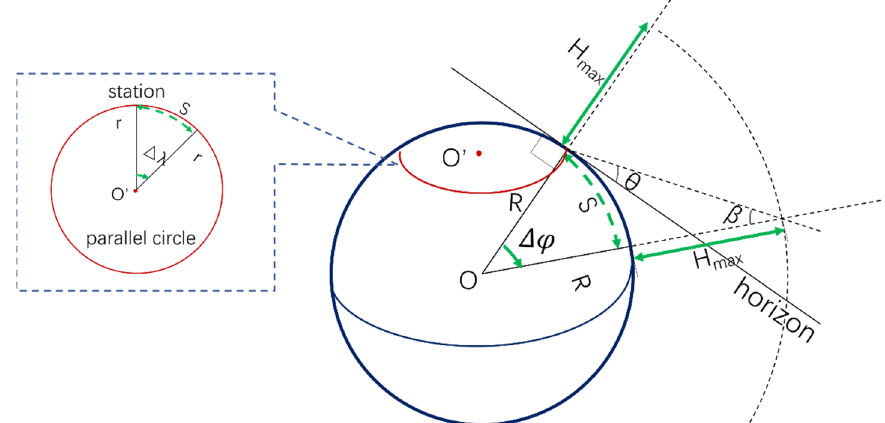
Figure 2. The ray-tracing land cover area.